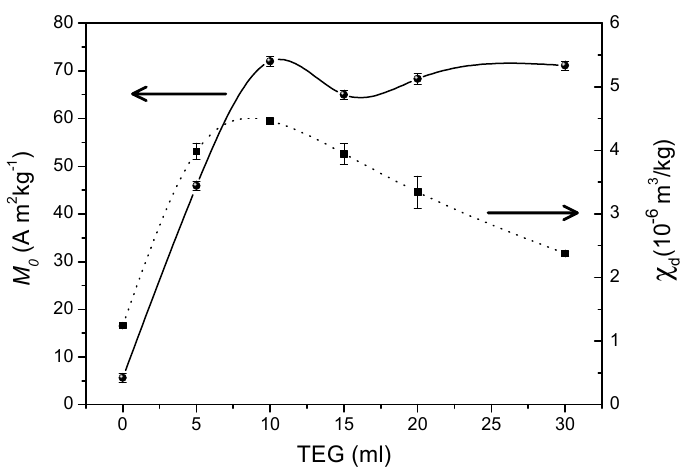
Figure 10. Saturation magnetization (extrapolated at zero field) and high field differential suscepti- bility ( χ d ) of Mn 2 Fe 2 O 4 NPs at 5 K with respect to different contents of triethylene glycol.